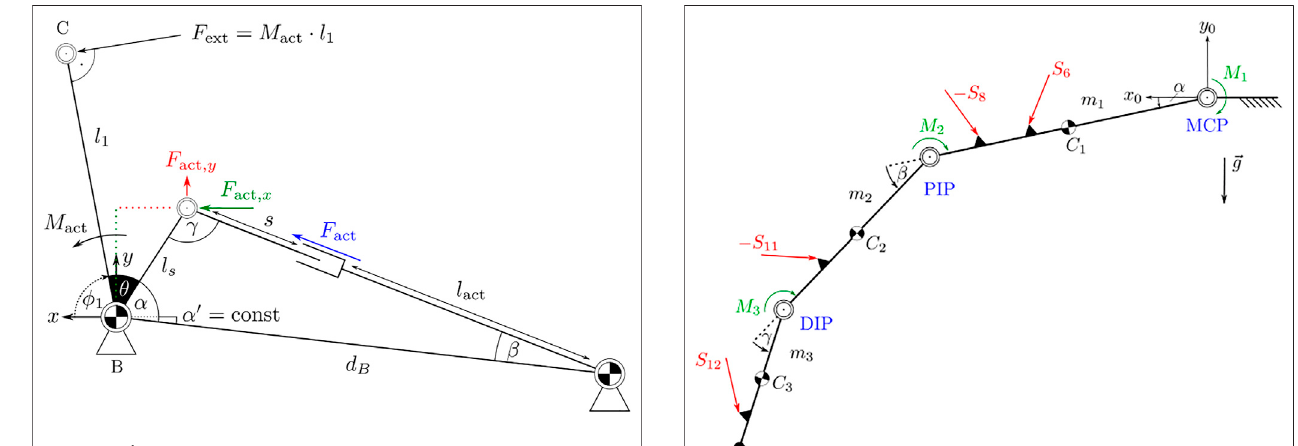
FIGURE 5 | Kinematic connection between actor and exoskeleton. The force F act generates the external momentum M act around point B.